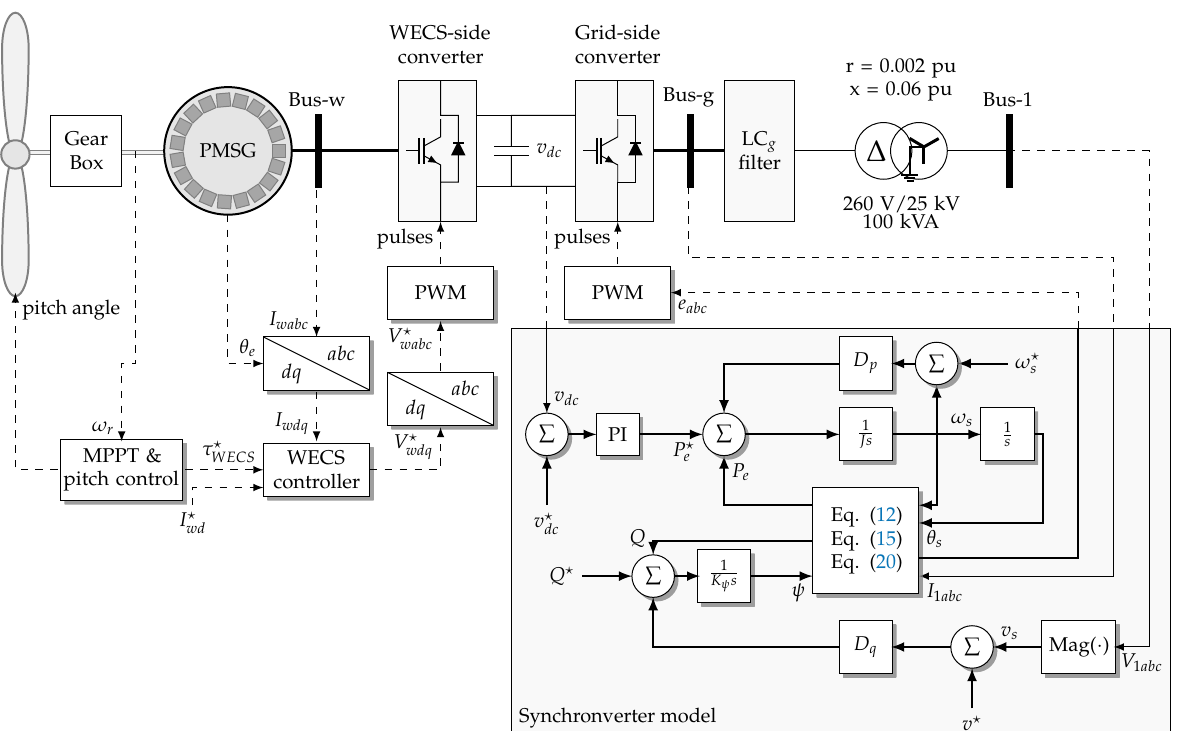
Figure 1. Schematic configuration of the synchronverter model and